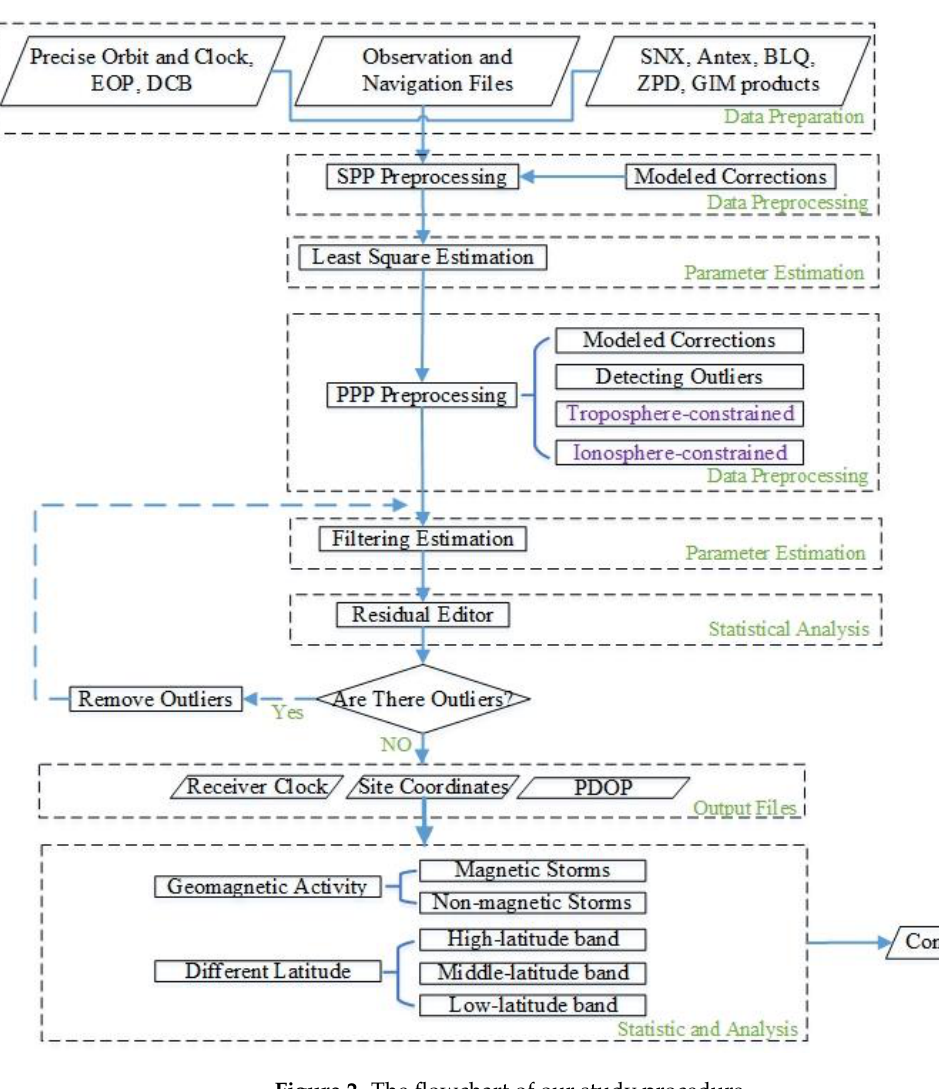
Figure 2. The flowchart of our study procedure.